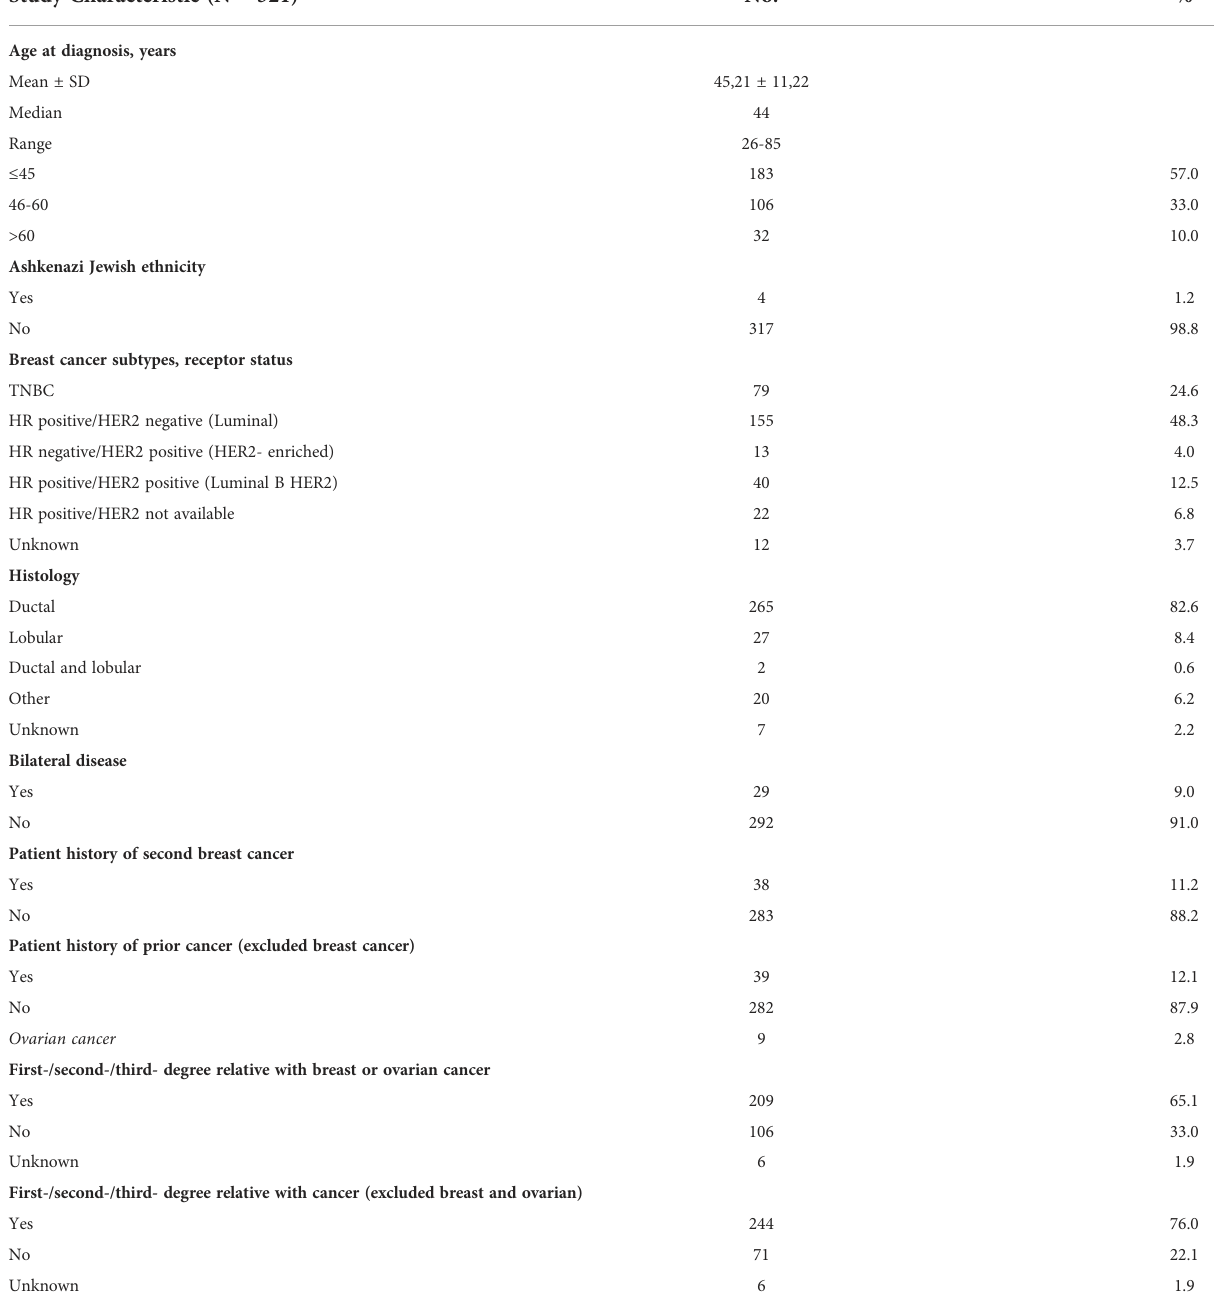
TABLE 1 Clinical and anatomopathological characteristics found in the 321 studied individuals. Study Characteristic (N =